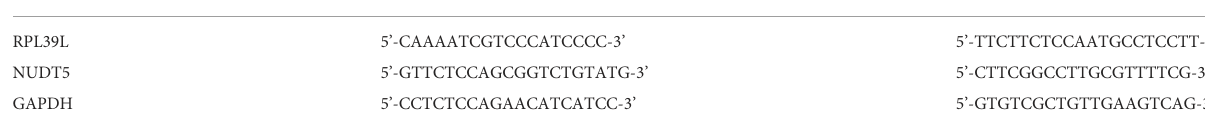
Primer sequences of genes.